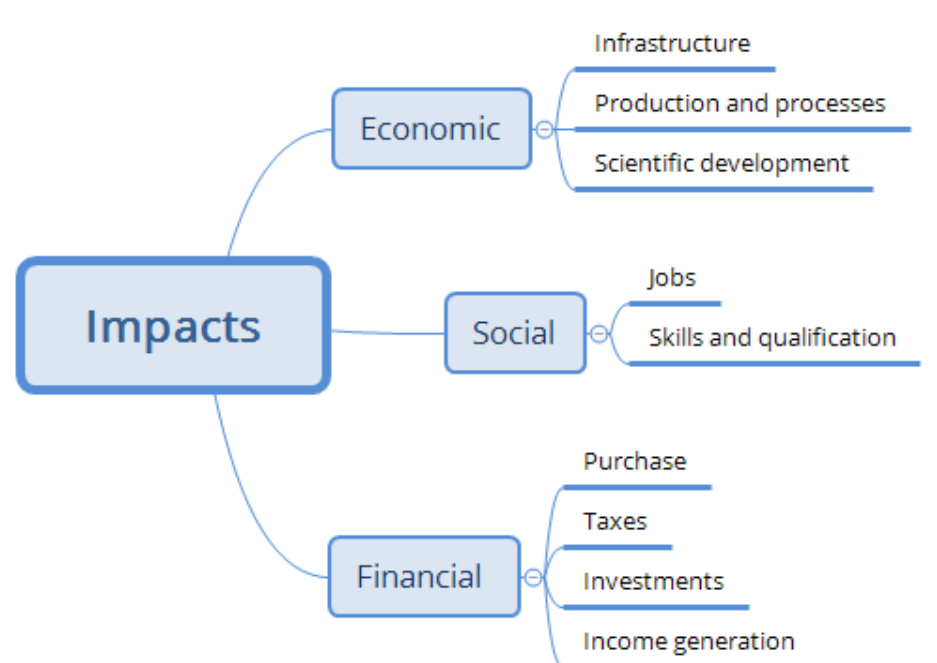
Figure 5. Evaluation model for the socioeconomic impact of university–industry collaborations.